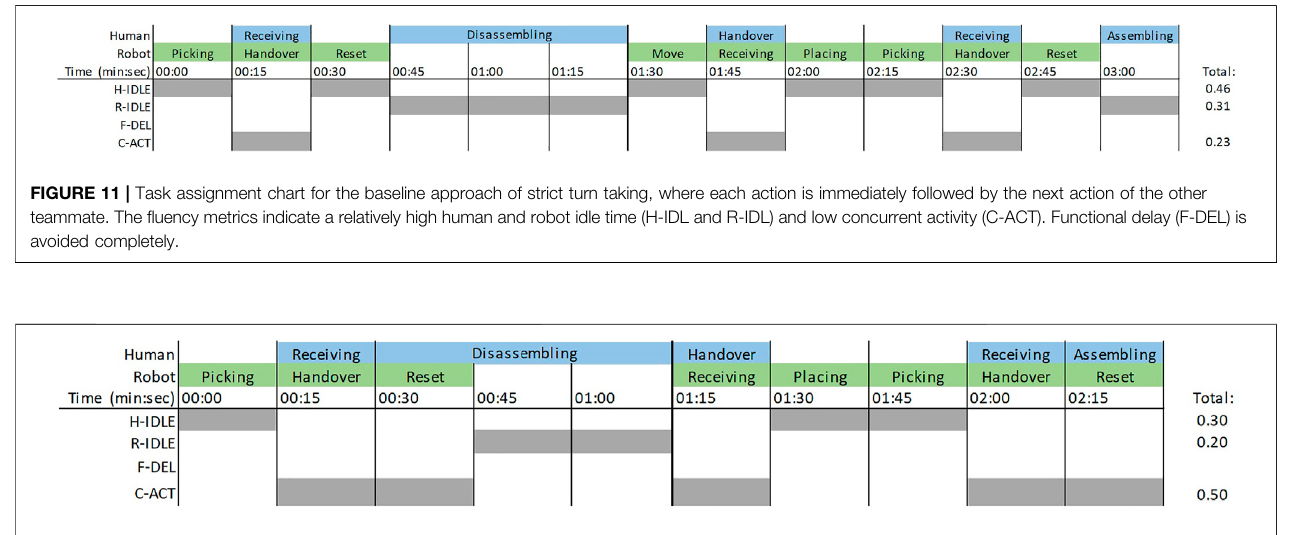
Frontiers in Robotics and AI |